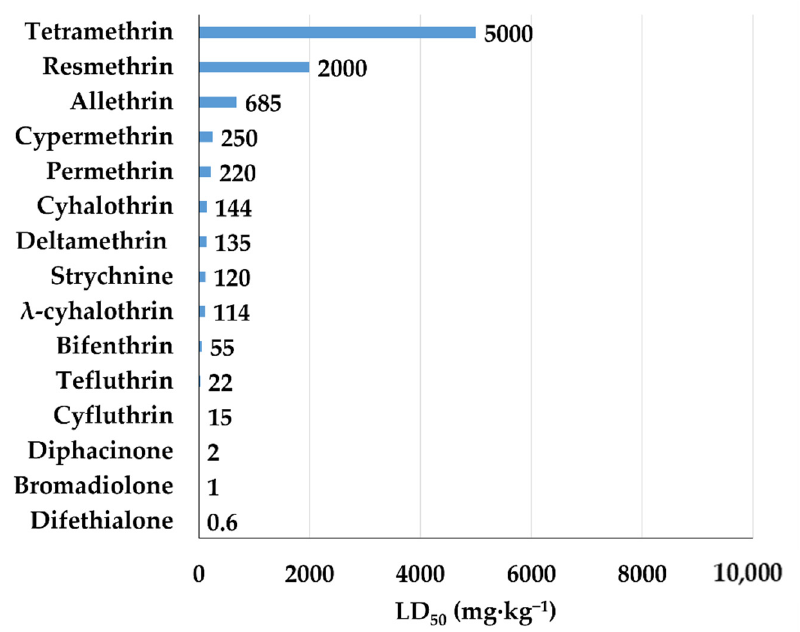
Figure 8. LD 50 (mg · kg − 1 ) of pyrethroids for rat.